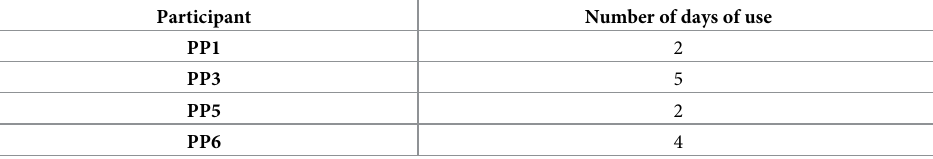
Table 7. Usage registration information obtained through the Web